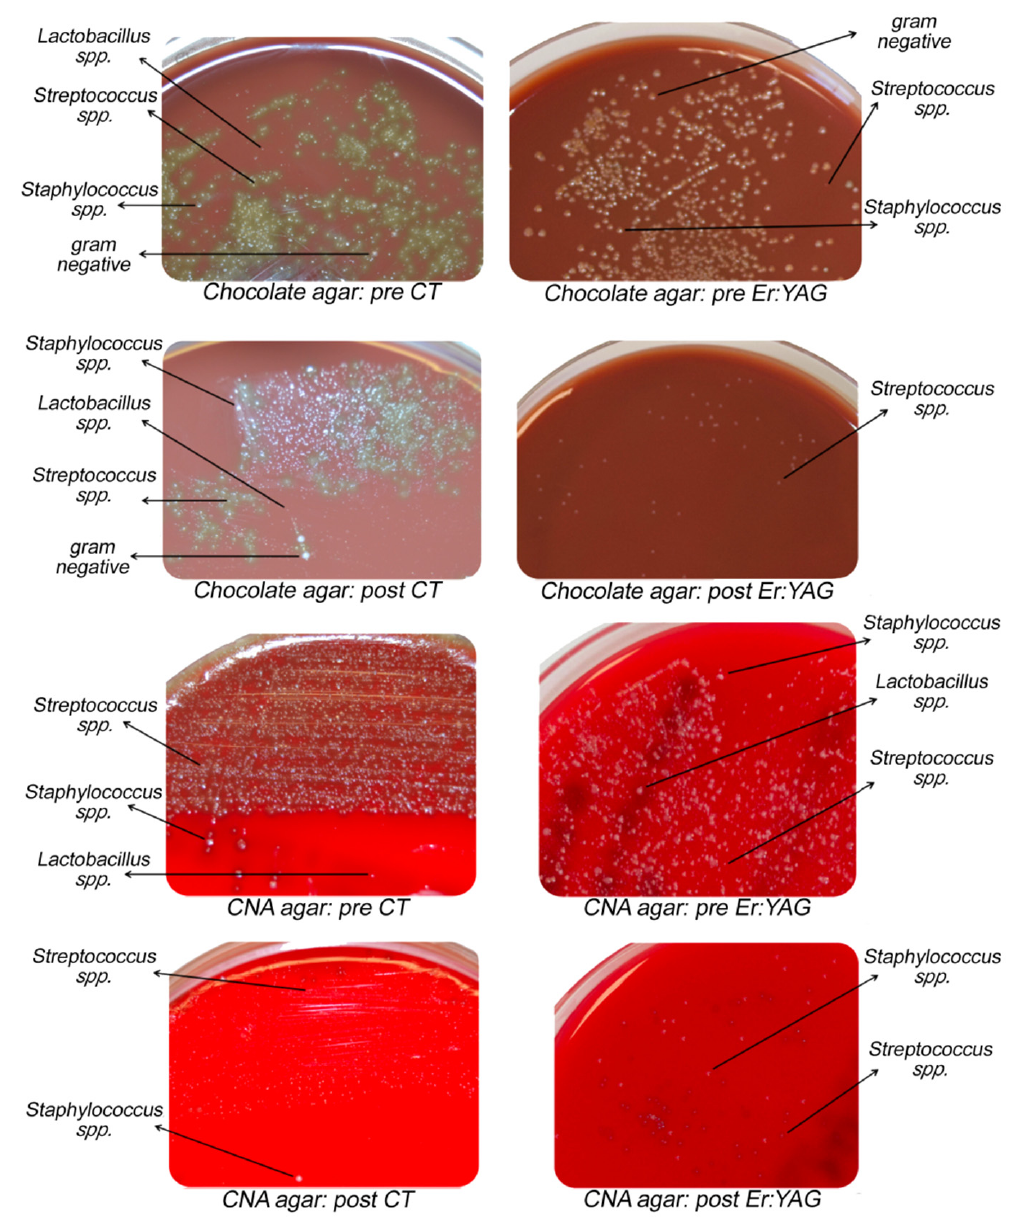
Figure 4. Difference in gram-positive and gram-negative colonies growth after Er:YAG treatments ( right ) vs. CT ( left ). Pre CT: pre-treatment with conventional therapy; post CT: post-treatment with conventional therapy; pre Er:YAG: pre-treatment with laser therapy; post Er:YAG: post-treatment with laser therapy.